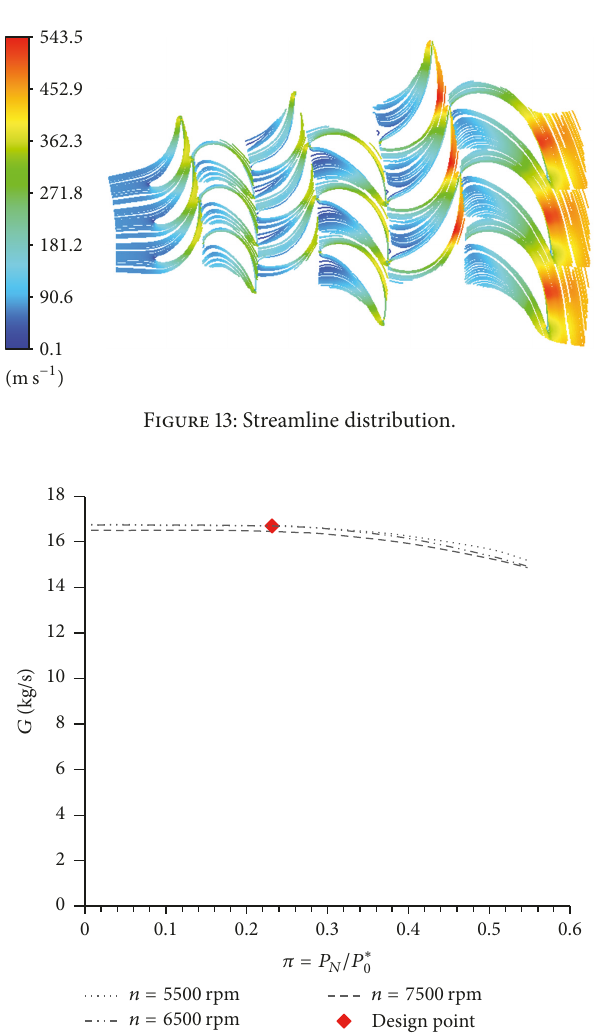
Figure 14: The variation of mass flow with pressure ratio at different speeds.